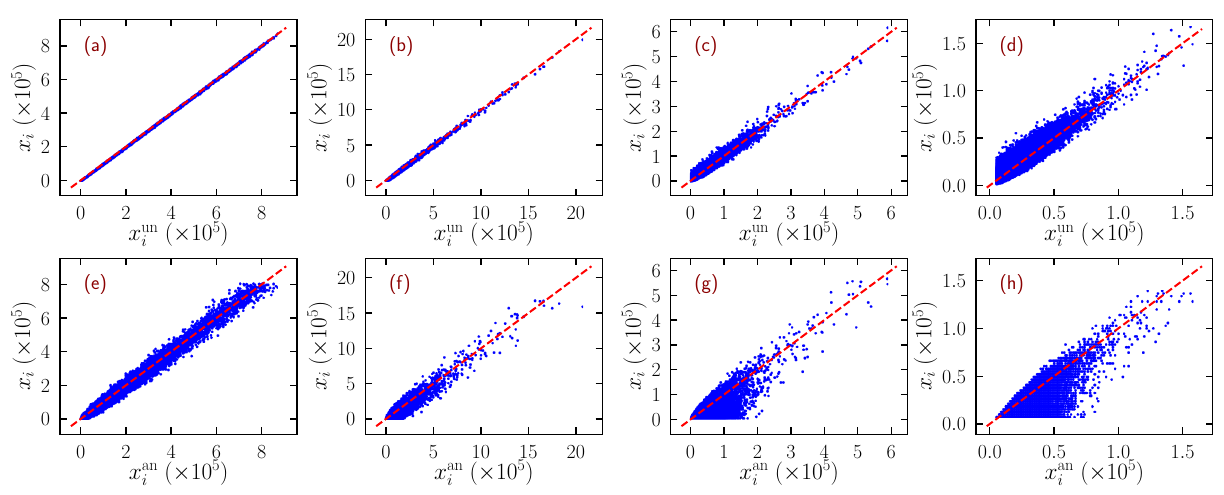
Figure 2. NBC for uncorrelated networks. Scatter plot of the numerical NBC x i in power-law UCM networks of size N = 10 6 with different degree exponent γ , as a function of the theoretical predictions x un i in Eq. (7) (top row) and x an i in Eq. (9) (bottom row). The dashed lines represent the curve y = x . Degree exponents considered are γ = 2.10 ( a ) and ( e ); γ = 2.75 ( b ) and ( f ); γ = 3.50 ( c ) and ( g ); γ = 4.50 ( d ) and ( h